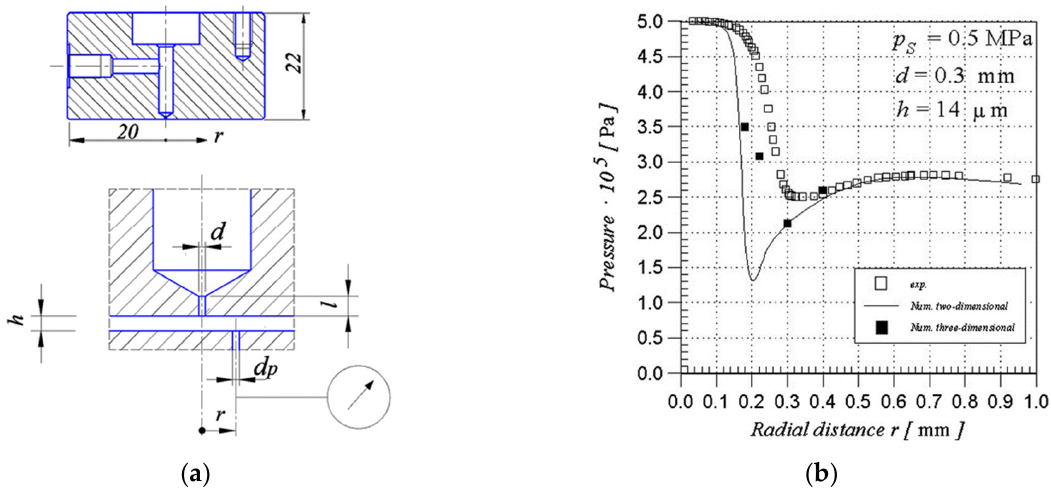
Figure 4. Schematic of flow intake and pressure distribution: ( a ) details of the flow intake, ( b ) pressure distribution of simulation and experiment [32].